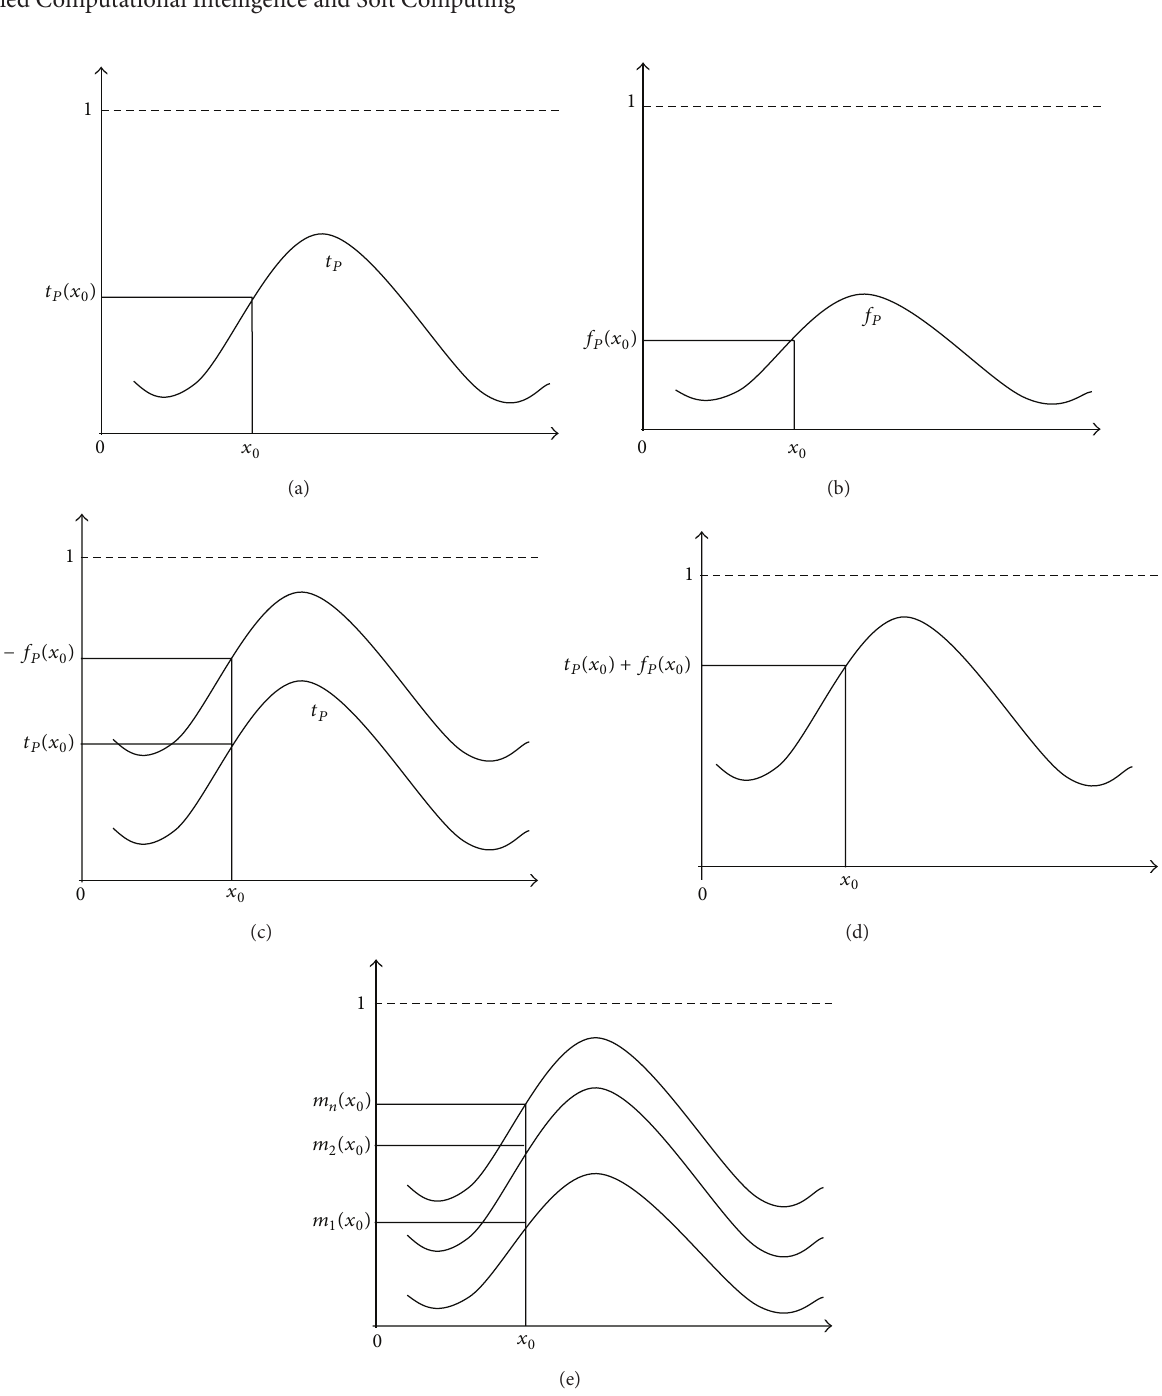
Figure 4: (a) Axiom 1, (b) Axiom 2, (c) Axiom 3, (d) Axiom 4, and (e) Axiom